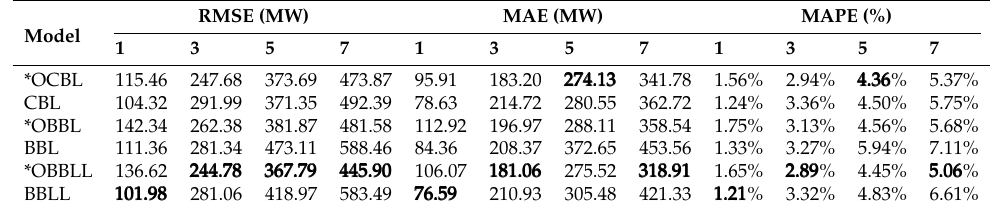
Table 4. Experimental results: average RMSE, MAE and MAPE in 2021. * indicates the model contains NODE